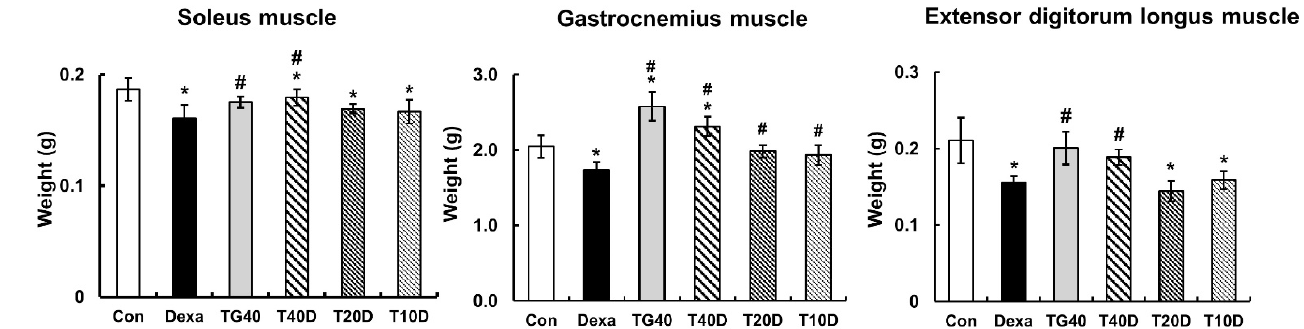
Figure 1. Body weight of rats before and after Dexa administration. The rats were supplemented with teaghrelin at 40 mg/kg (TG40) or with saline (Con) for 10 days, and Dexa was injected into the rats in the last five days, with the supplementation of teaghrelin (0, 10, 20 or 40 mg/kg, Dexa, T10D, T20D, or T40D) for 10 days. During the experimental period, the body weight of the rats was measured daily. The results were analyzed using one-way ANOVA. Values are presented as the mean ± SD (n = 5 or 6). * p < 0.05 versus Con; # p < 0.05 versus Dexa.